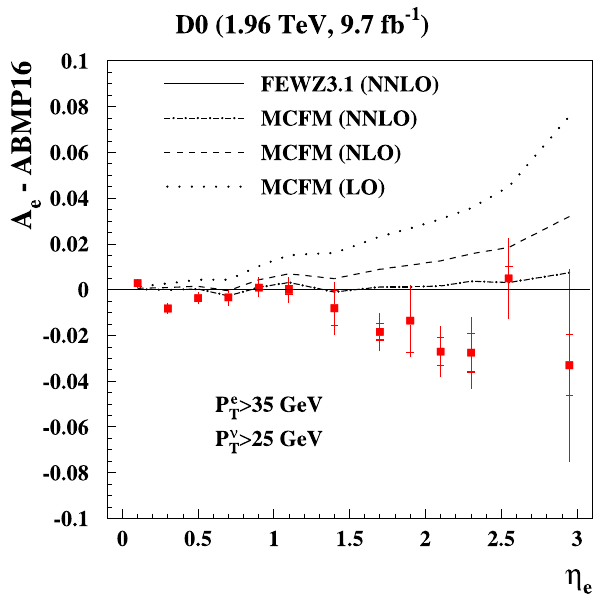
Fig. 14 Same as Fig. 13 using predictions by the MCFM code